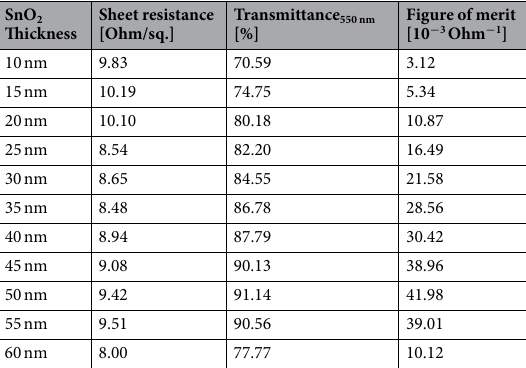
Table 2. Sheet resistance and optical transmittance of thermally evaporated SnO 2 /APC/SnO 2 multilayer film grown on a PET substrate as well as the calculated figure of merit as a function of SnO 2 layer thickness at a fixed APC thickness of 10 nm.